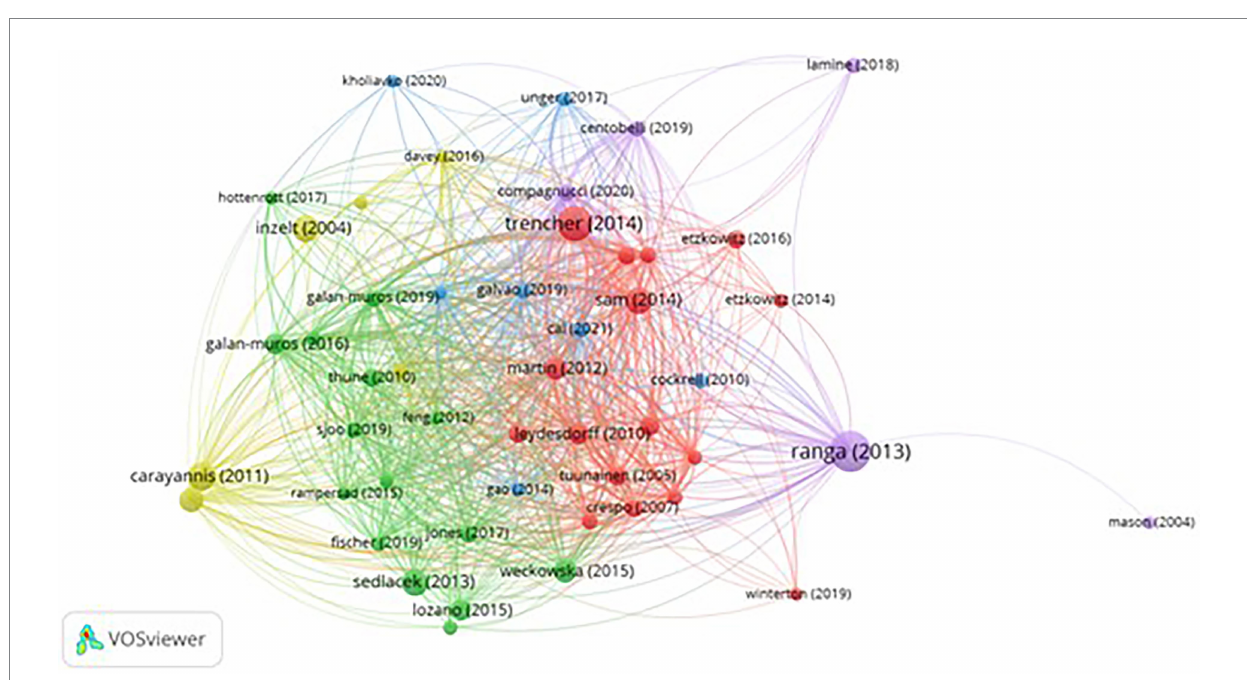
FIGURE 4 Bibliographic coupling analysis of helix model and